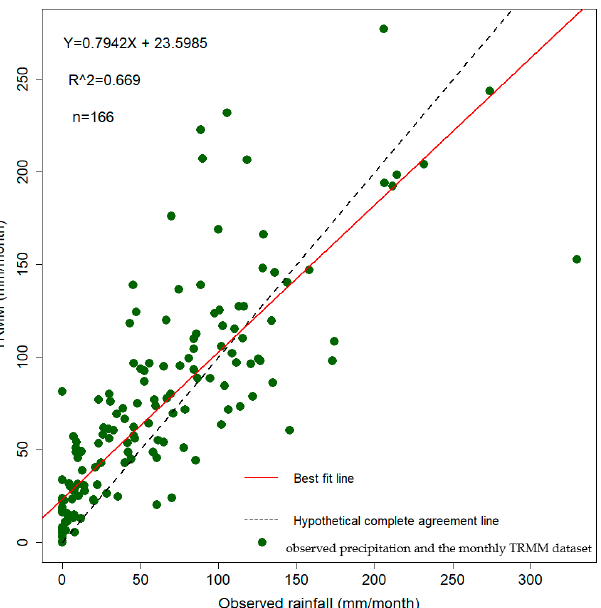
Figure 3. Recorded rainfall data comparison from Sangaw Agricultural Weather Station versus TRMM data for the same pixel from September 2001 to December 2019.